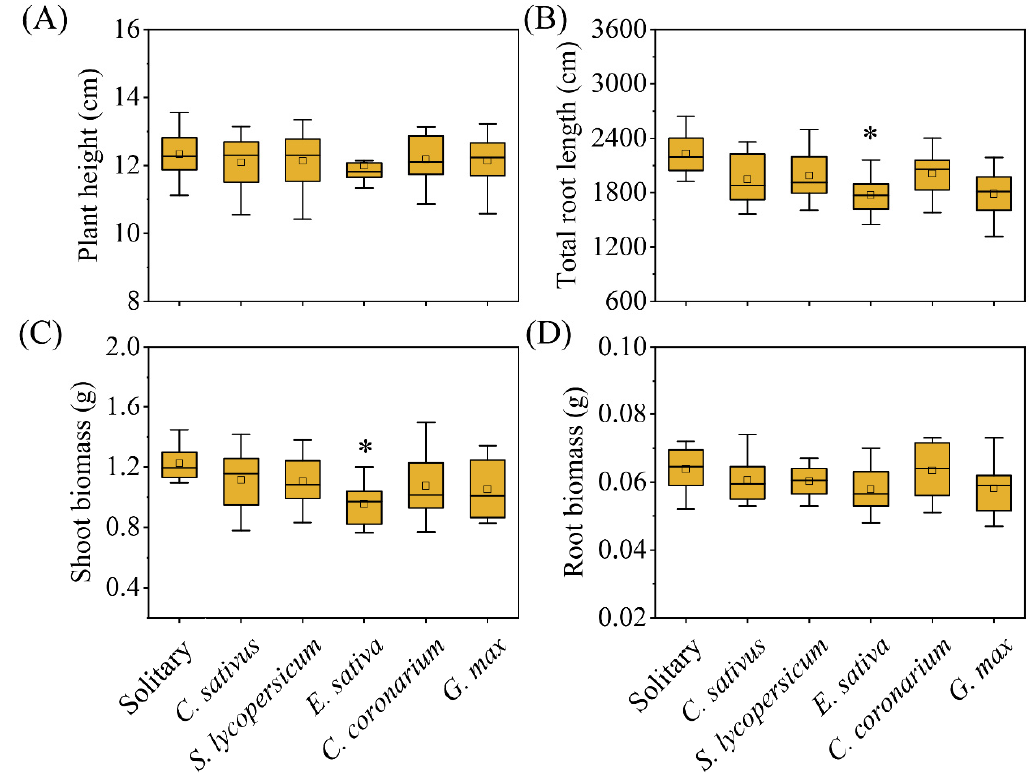
Figure 2. The growth responses of C. sativus to different competition treatments. * indicates a significant difference in ( A ) plant height, ( B ) total root length, ( C ) shoot biomass, and ( D ) root biomass between competition and solitary treatment ( p < 0.05).